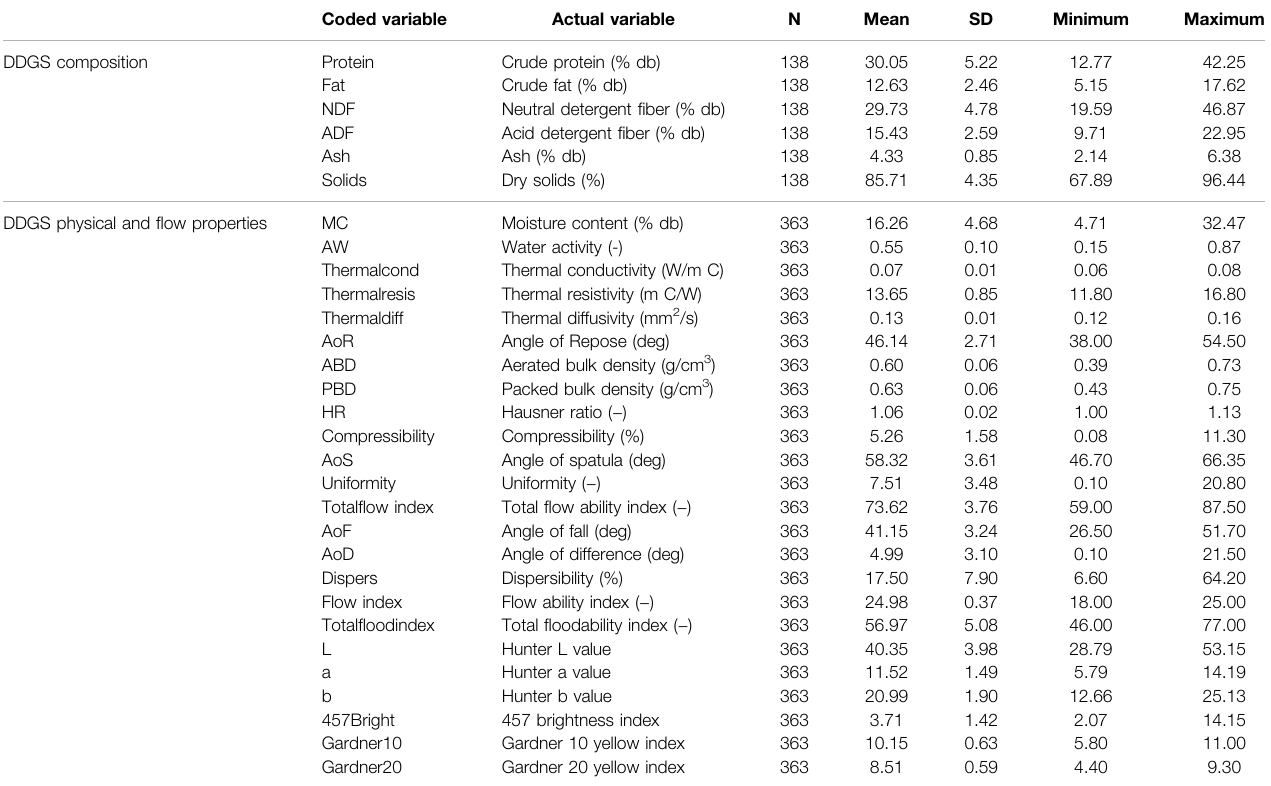
TABLE 2 | Summary statistics for each dependent variable measured in the study.